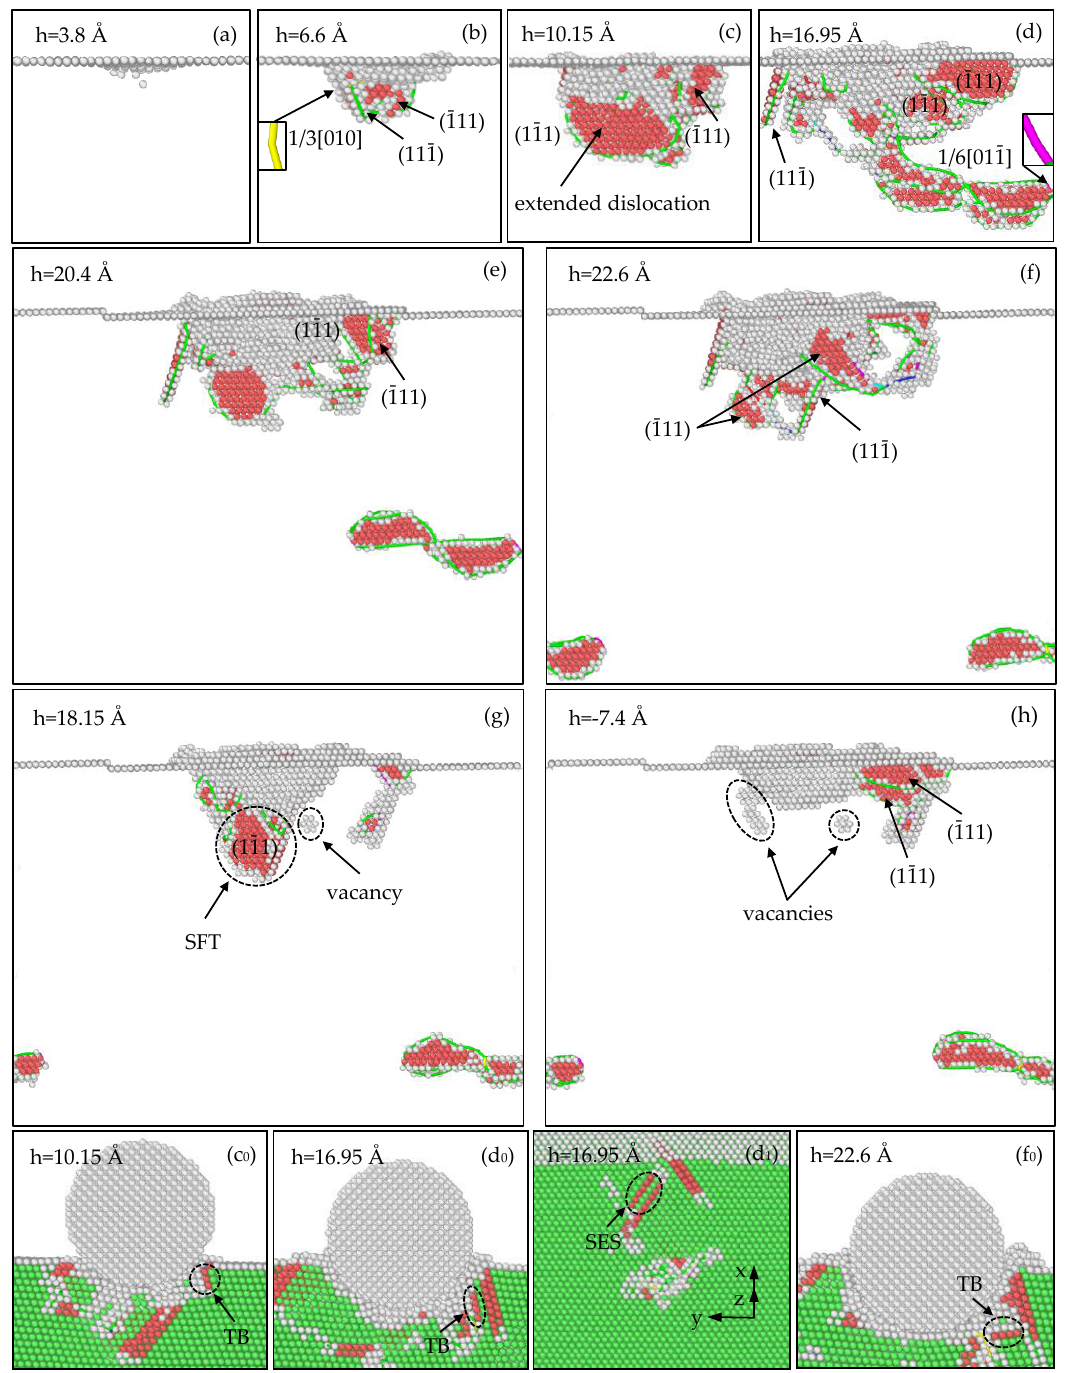
Figure 6. Defect evolution in the (111) sample during the loading process ( a – f , c 0 – f 0 , d 1 ), and the unloading process ( g – h ). (SFT is the stacking fault